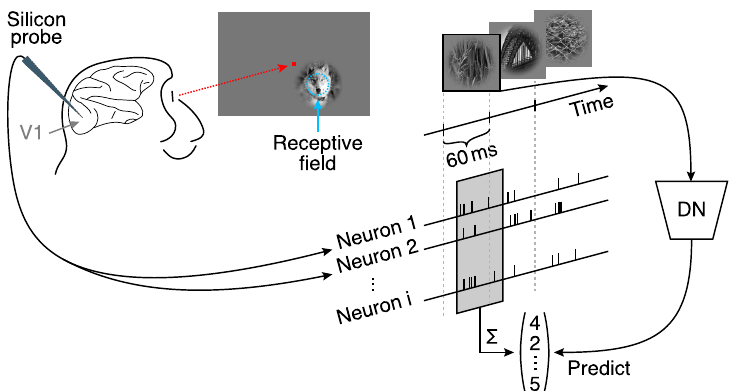
Fig 2. Experimental paradigm from Cadena and colleagues [14]. Natural images were flashed to a monkey covering 2˚ of their visual angle, and located at the center of the multi-unit receptive field. Multiple neurons were isolated from recordings with silicon probes inserted into V1 [41]. Natural images were shown in a fast sequence without blanks, each presented for 60 ms. Spike counts from all isolated neurons corresponding to each image were extracted from a window 40 ms after the image onset lasting 60